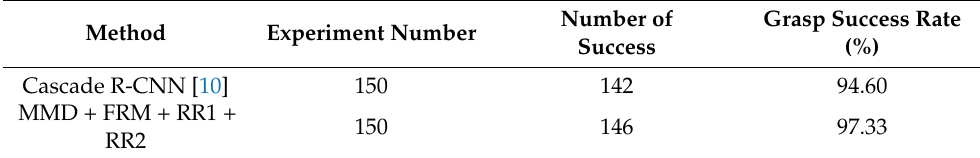
Figure 11. The grasp process in actual scences. During the experiment, the number of grasps and success for each object were counted. And the final results are shown in Table 6. Table 6. Comparison of experimental results before and after